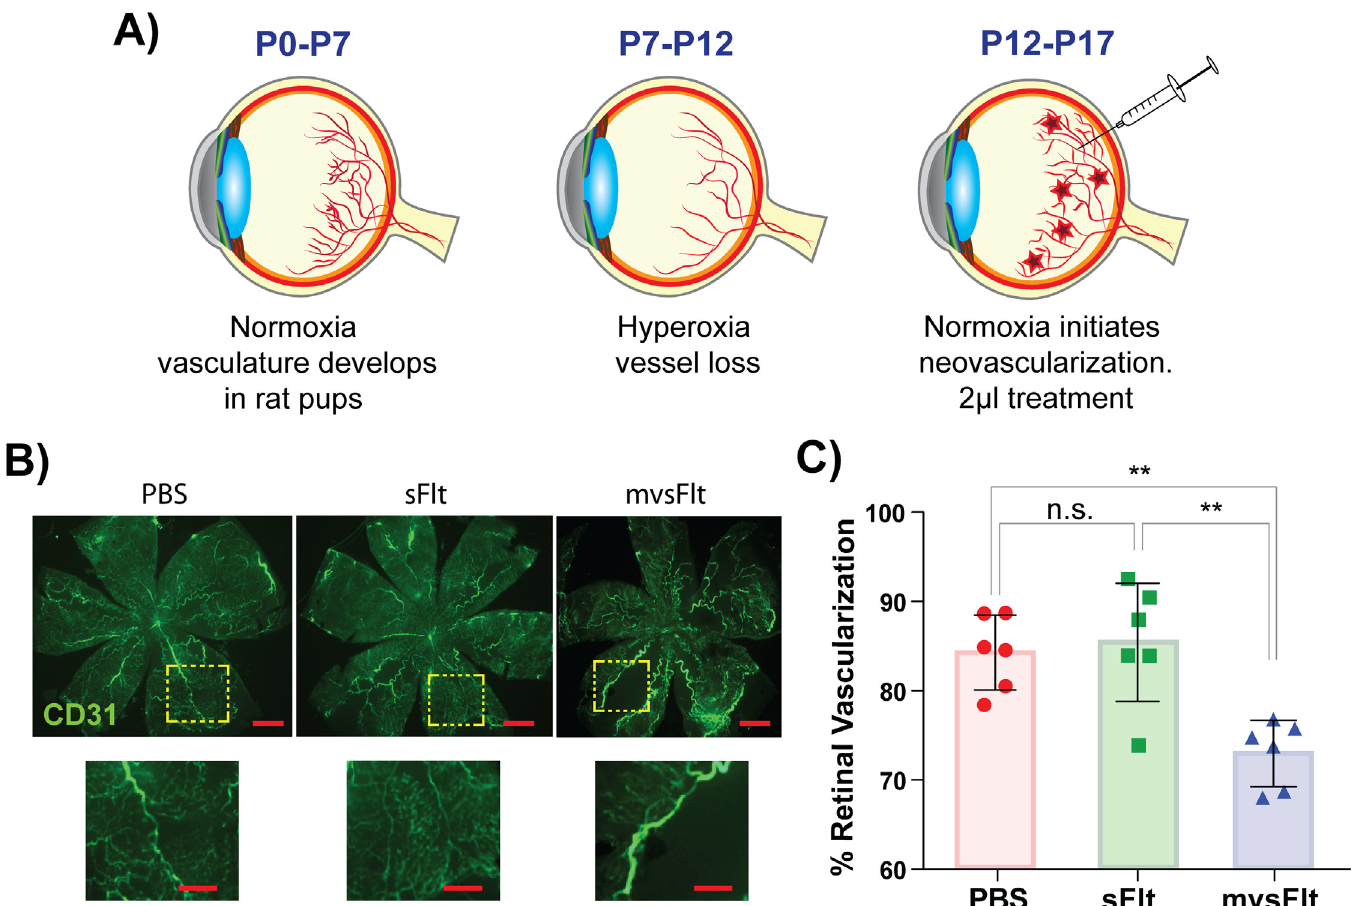
Fig 4. mvsFlt inhibits retinal angiogenesis. A) Schematic showing methods used for carrying out the OIR model. Newborn rat pups were housed in normoxic conditions (21% oxygen, room air) from post-natal day (P) 0 – 7 to allow for normal retinal vasculature development and then transferred to hyperoxic conditions from P7-P12, which induces vessel pruning. At P13, the pups are transferred back into normoxic conditions and treated with 2 μ l of PBS, sFlt or mvsFlt and sacrificed at P17. B) Representative images of retinas treated with PBS, sFlt and mvsFlt. Prior to sacrifice, rat pups were injected with fluorescently-tagged 2 MDa dextran to visualize vessel coverage. Scale bar corresponds to 250 μ m. Dashed boxes magnify that portion of tissue (scale bar corresponds to 100 μ m). C) Quantified retinal vascularization after 5 days of treatment. Percent retinal vascularization was calculated by comparing the area of vascularization to the total retinal area in the image. One-way ANOVA gives p-value *** < 0.001 (n.s.-not significant; ** p <